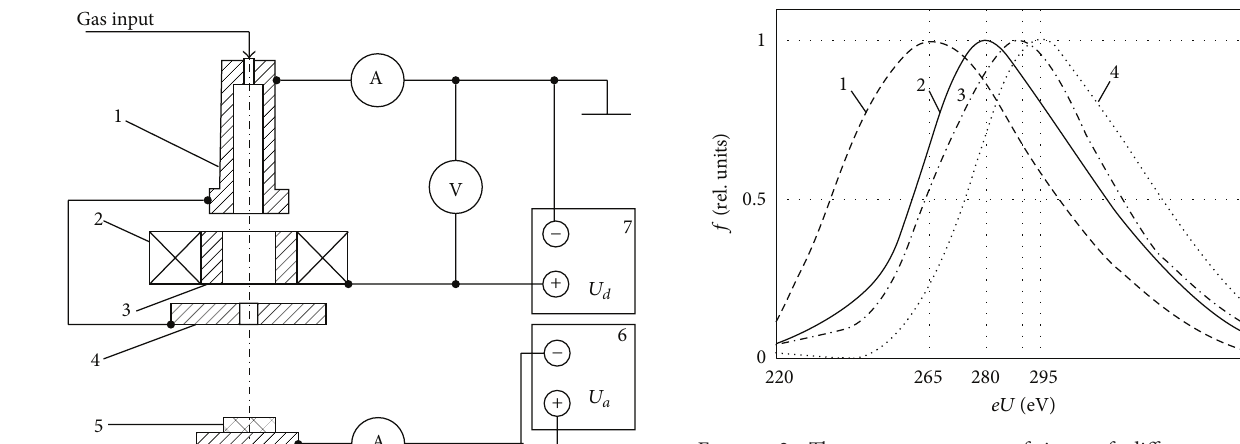
Figure 2: The energy spectra of ions of different gases. 1: dimethyldichlorosilane; 2: air; 3: propane; 4: argon; 𝐼 𝑑 = 0.2 A, Q = 2.4 m 3 × mPa/s. Δ𝐸 , eV: 1: 64; 2: 53.5; 3: 56; 4: